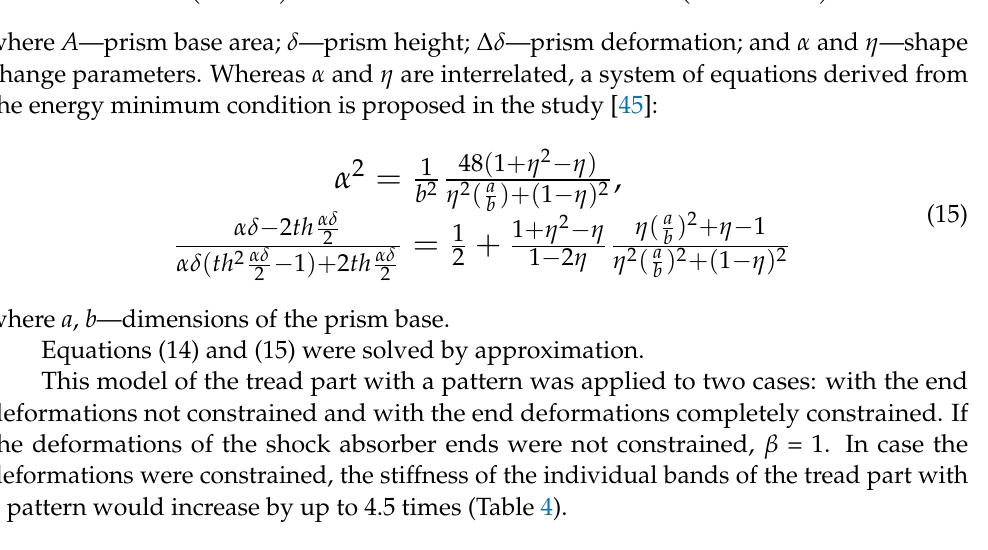
Table 4. The values of the stiffening coefficient of the tread elements for individual tread bands. Tire